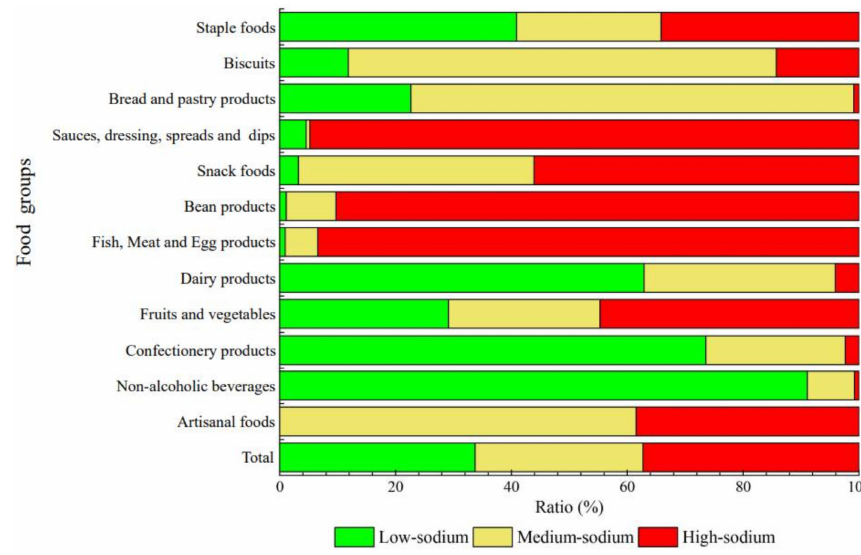
Figure 1. The proportion of low-, medium-, and high-sodium content in food groups.